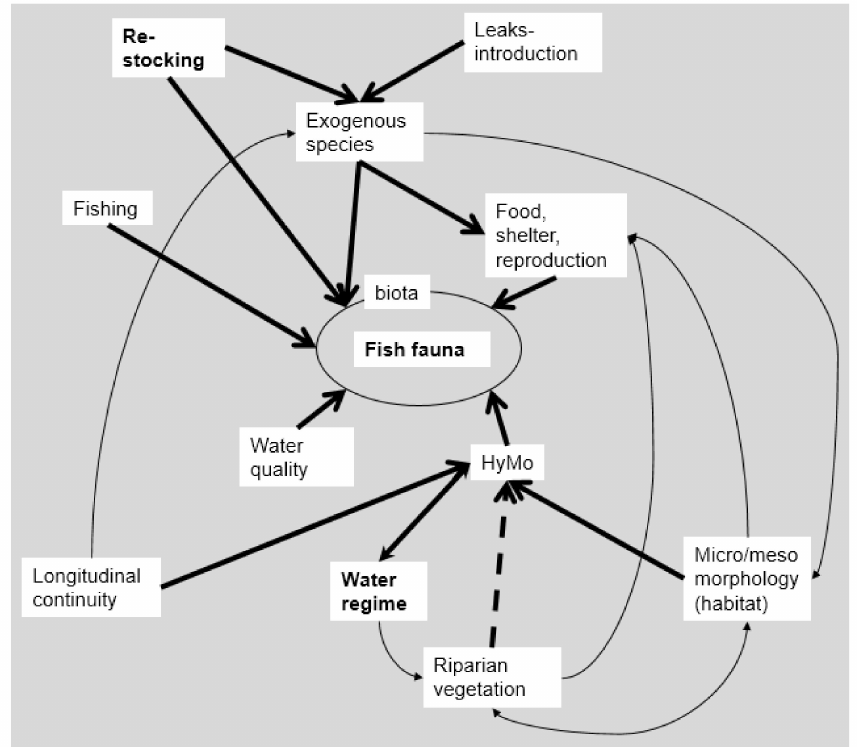
Figure 2. The cause–effect network for fish fauna, not to be confused with a Value tree which is a hierarchical organization of the reasons why a factor is considered important by some stakeholder (see [7] for a discussion of this difference; in [25] a more practical perspective can be found). If instead we switch from the original WFD position to a more balanced vision, with a value tree where each component deserves its place at the same hierarchical level (Figure 1, bottom), and, in parallel, we adopt for the overall index an aggregative structure other than ‘worst case’, this problem can be solved. Indeed, under such a position, it is possible to state that the improvement of just a single component (e.g., Biota, water quality or